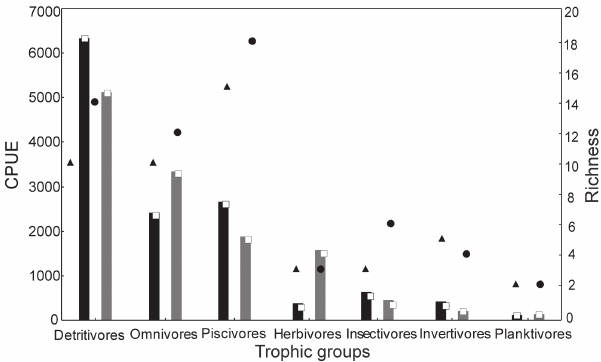
Fig. 2 . Total fish abundance (CPUE: black bars = lentic; gray bars = lotic) and richness (species number: lotic; lentic) per trophic groups and per habitats along the period of